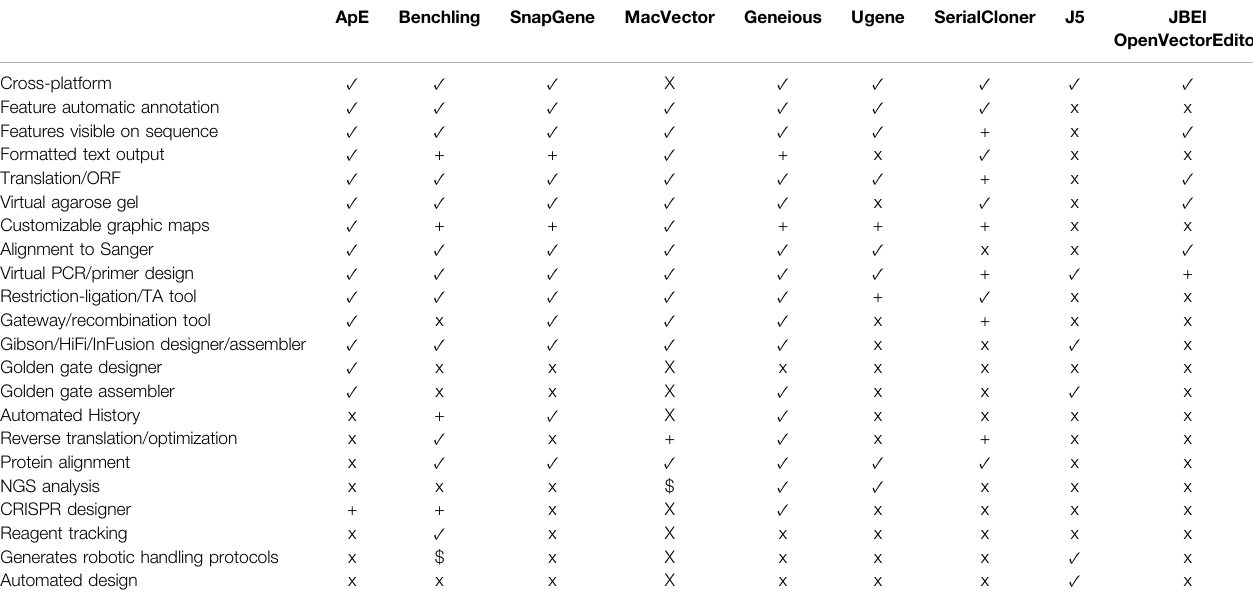
TABLE 1 | Functions available in ApE and other free or commercial software. ApE